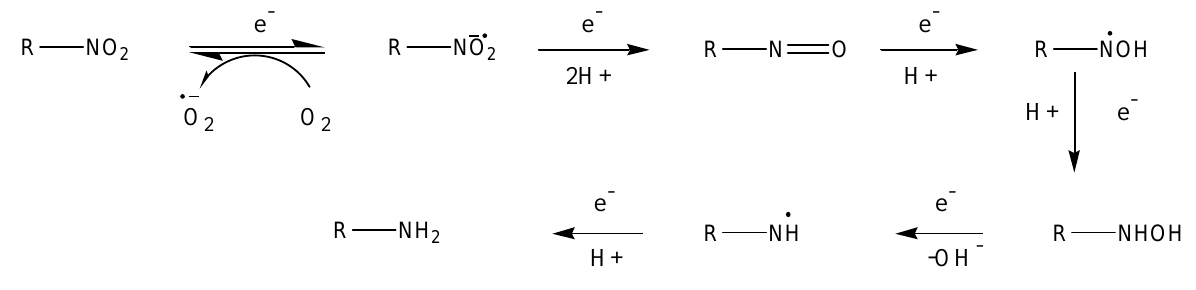
Scheme 4 . Generalised reduction pathway for nitro-heterocycles